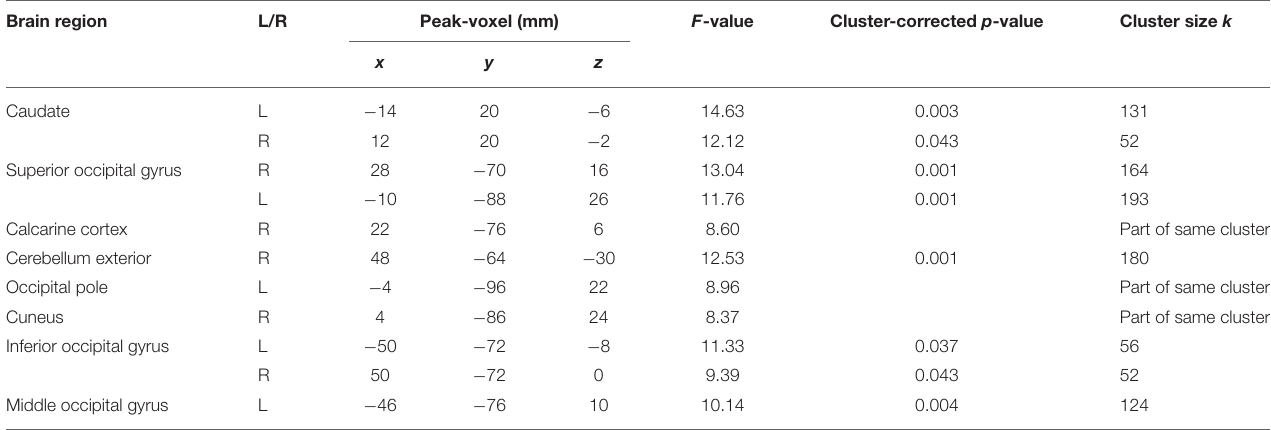
TABLE 3 | Functional activity associated with the main effect of probability ( n =